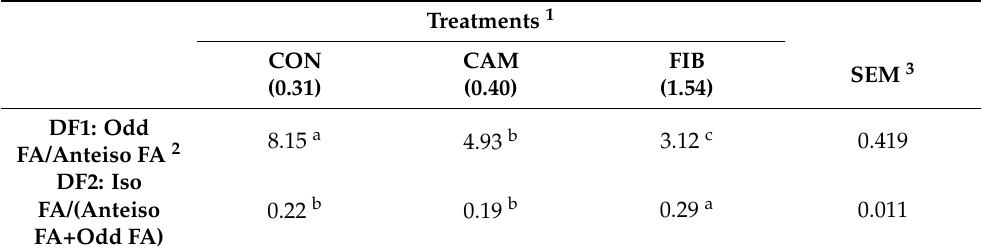
nating ability in the discriminant functions (DF) 1 and